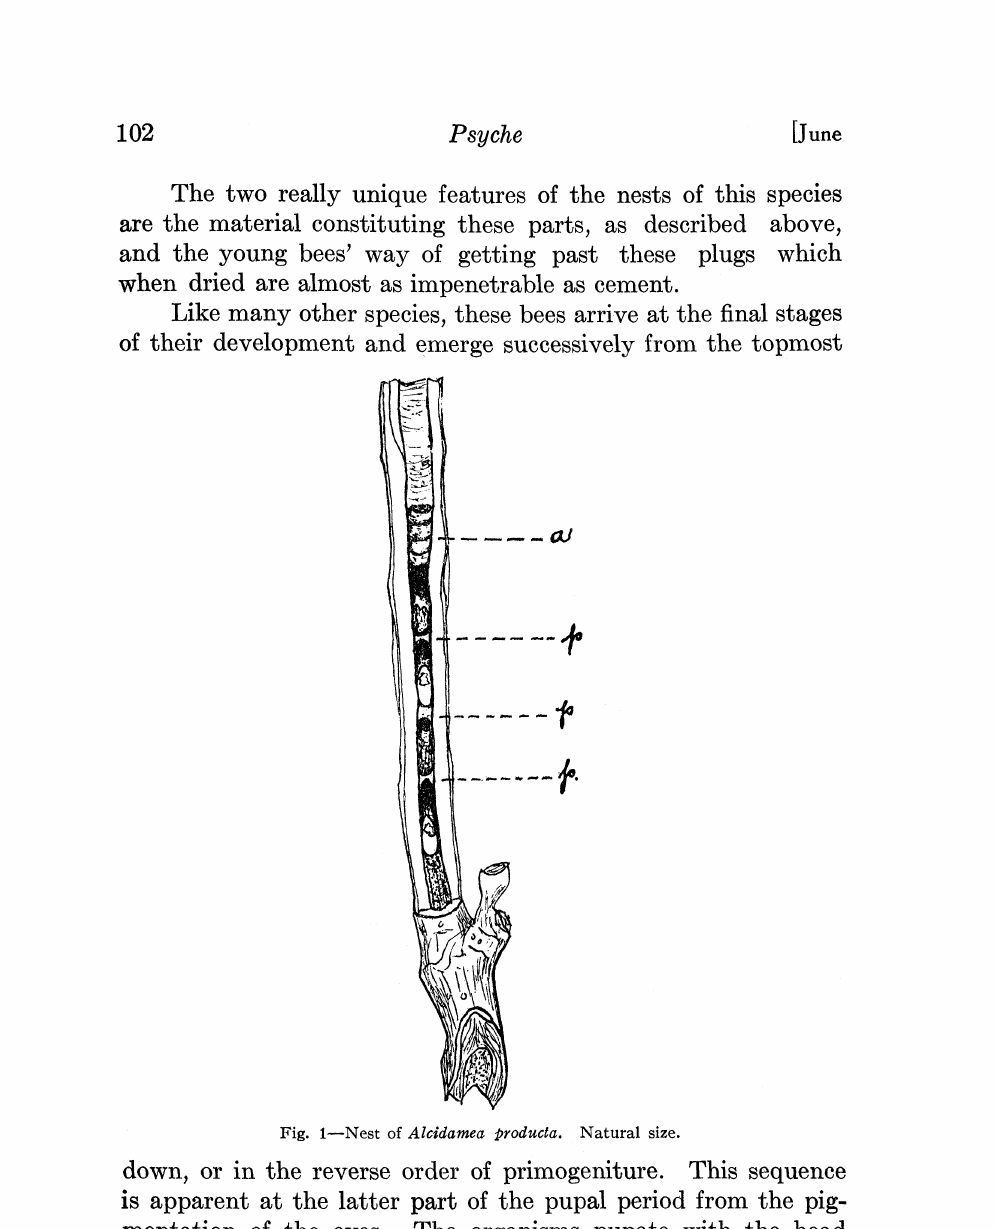
Fig. 1--Nest of Alcidamea producta. Natural